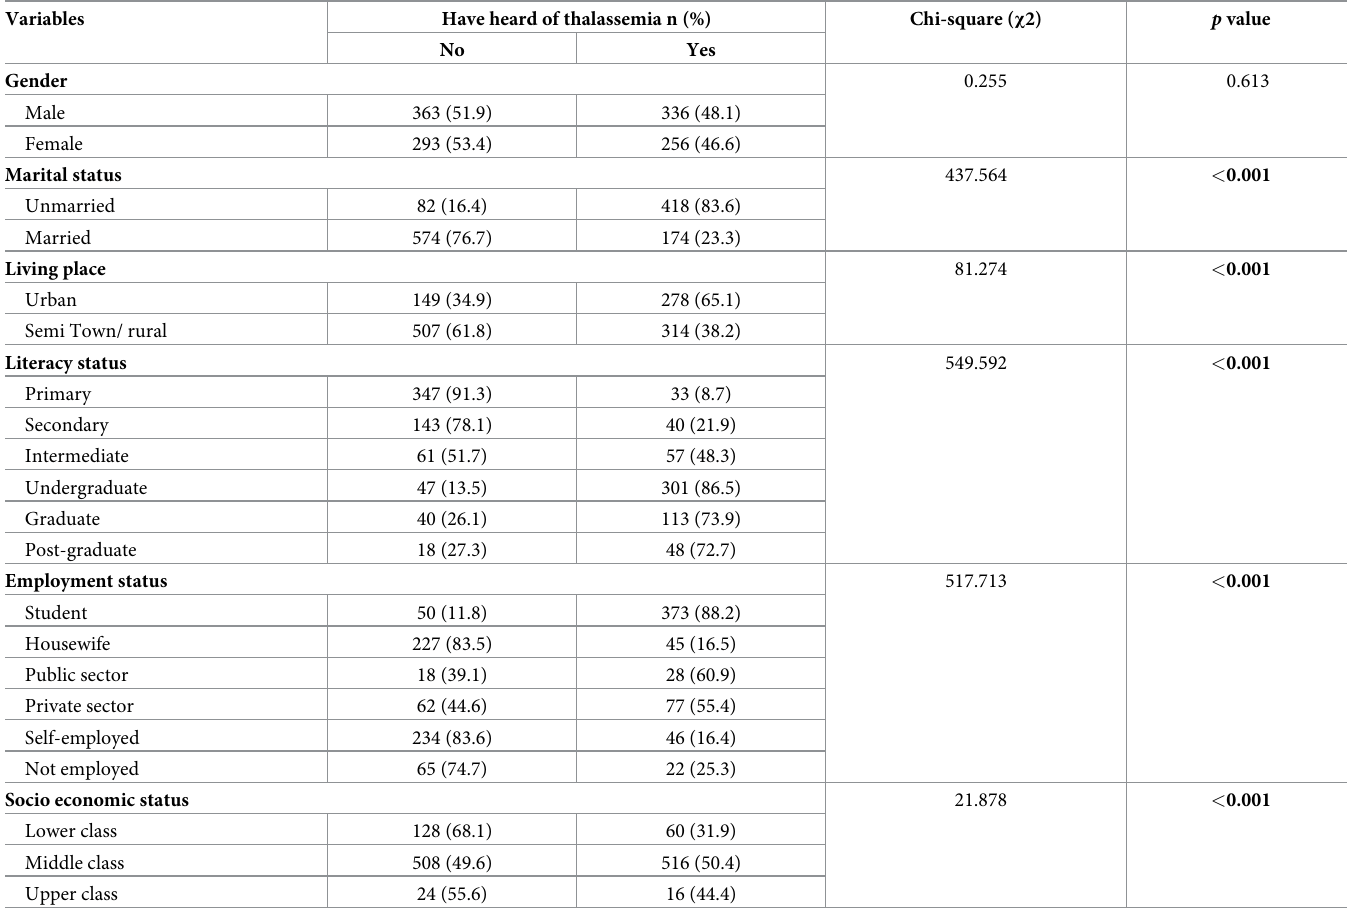
Table 2. Demographic characteristics of participants and proportion who have heard of thalassemia (n = 1,248).